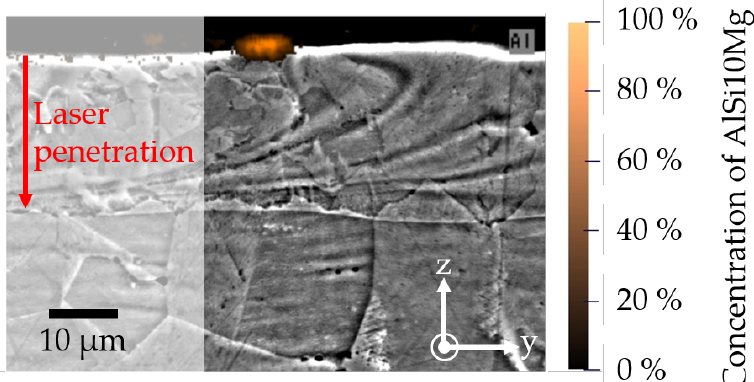
Figure 6. SEM image of a longitudinal microsection with a superimposed EDS mapping of AlSi10Mg showing a single AlSi10Mg powder particle after single-track melting; the laser scanning direction was in the positive y-direction.